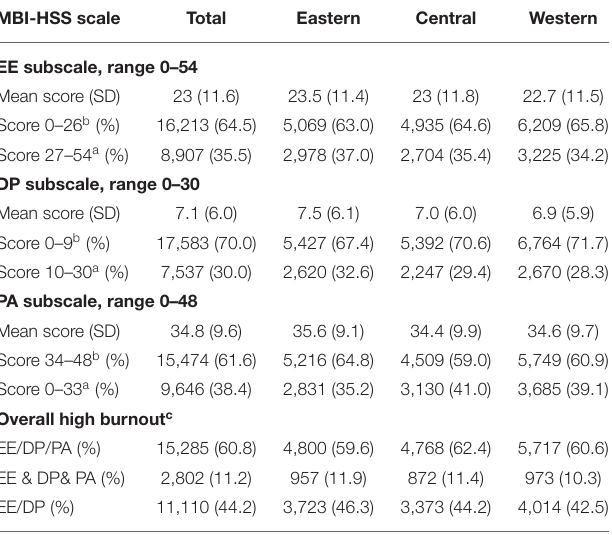
TABLE 2 | Measures of burnout among medical professionals in China. TABLE 3 | Responses to the ICECAP-A scale among Chinese medical